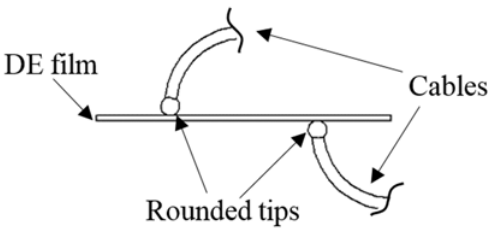
Figure 5. The lead contact method.